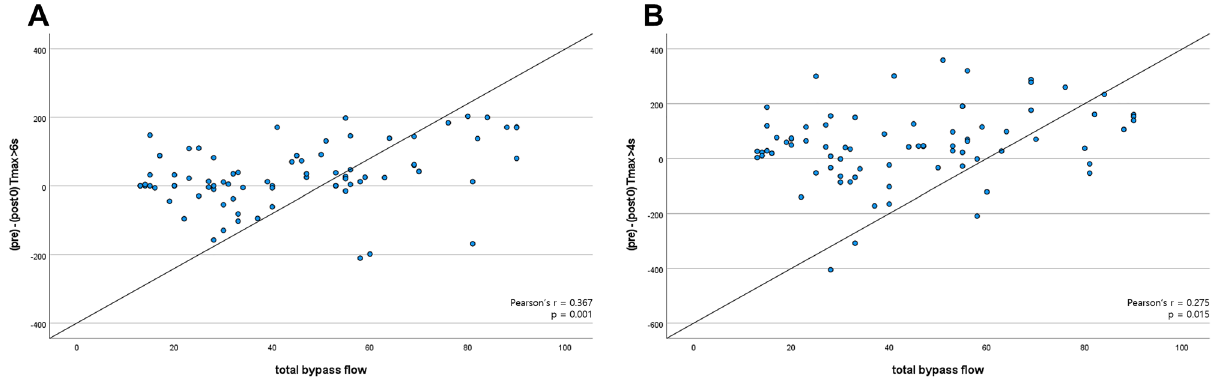
Figure 3. ( A : The amount of change in Tmax > 6 s pre- and immediately postoperatively was correlated with the amount of STA flow measured during surgery (Pearson’s r = 0.367, p = 0.001). ( B ) The amount of change in Tmax > 4 s pre- and immediately postoperatively was correlated with the amount of STA flow measured during surgery (Pearson’s r = 0.275, p =